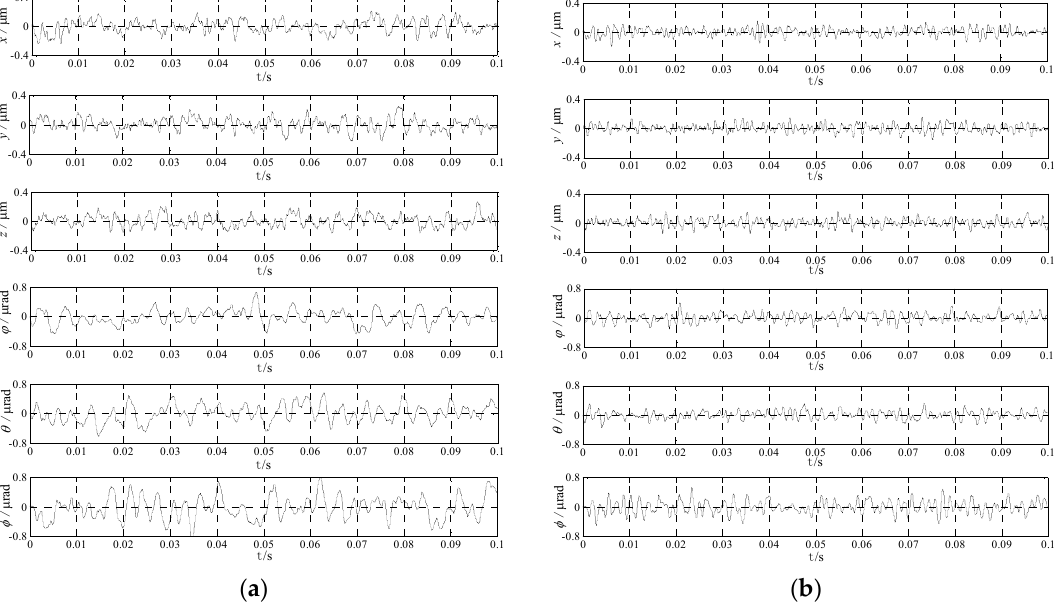
Figure 7. Position response curve: ( a ) the response curve under external disturbance with ADRC; and ( b ) the response curve under external disturbance with improved ADRC.